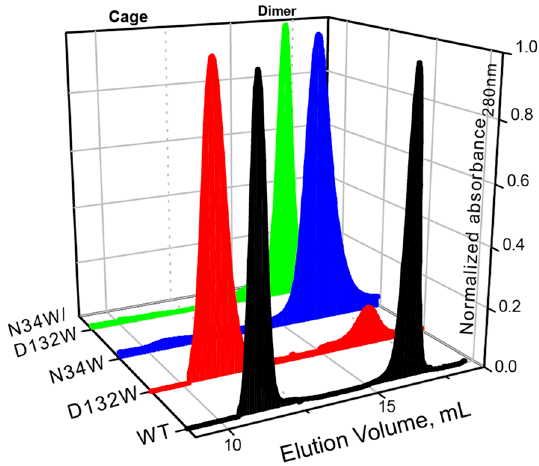
Figure 2. SEC chromatograms of BFR wild type (WT) and three B-site interface mutants, showing that two mutants—N34W and D132W/N34W—form solely dimer, while D132W forms mostly 24-mer